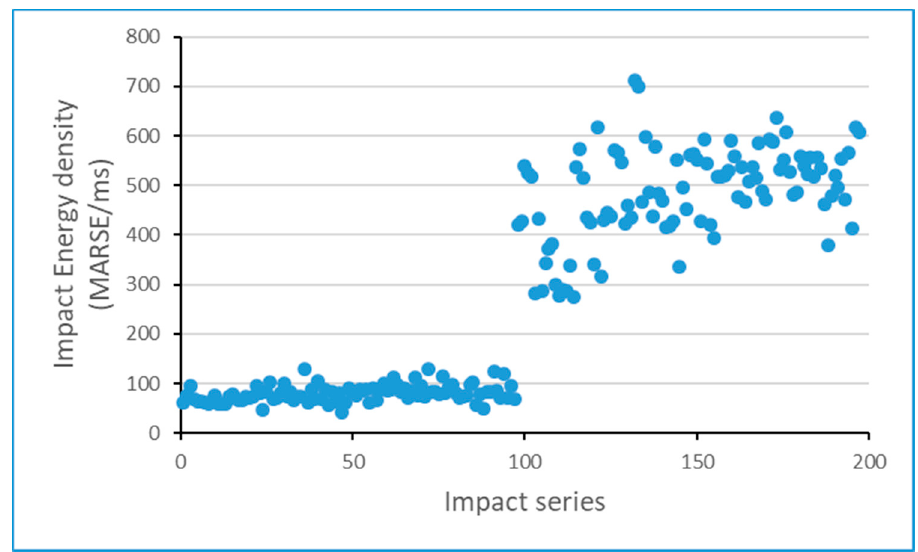
Figure 4. Sensor readout showing the energy density for each impact in a single point impact fatigue tester (SPIFT) series .